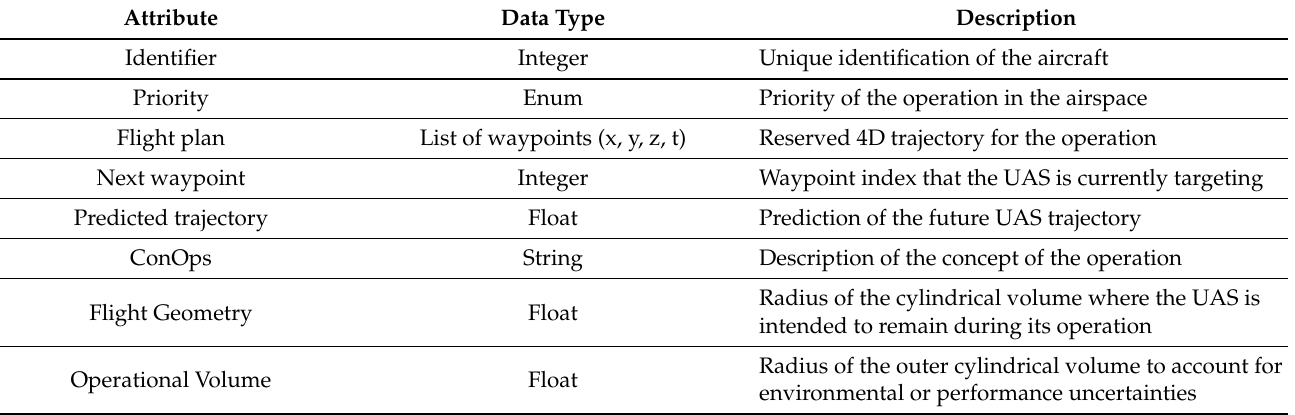
Table 3. Attributes of a UAS operation object.